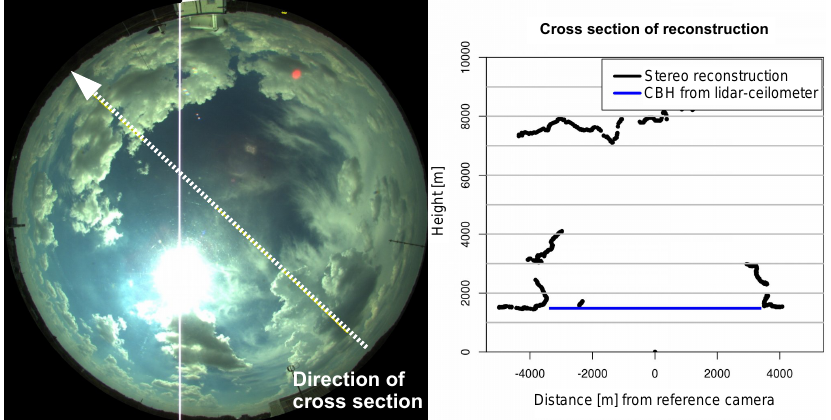
Figure 17. Cross section of the reconstruction from 24 July 2014, 12:07:00UTC, and highlighted cloud-base height from the lidar-ceilometer.